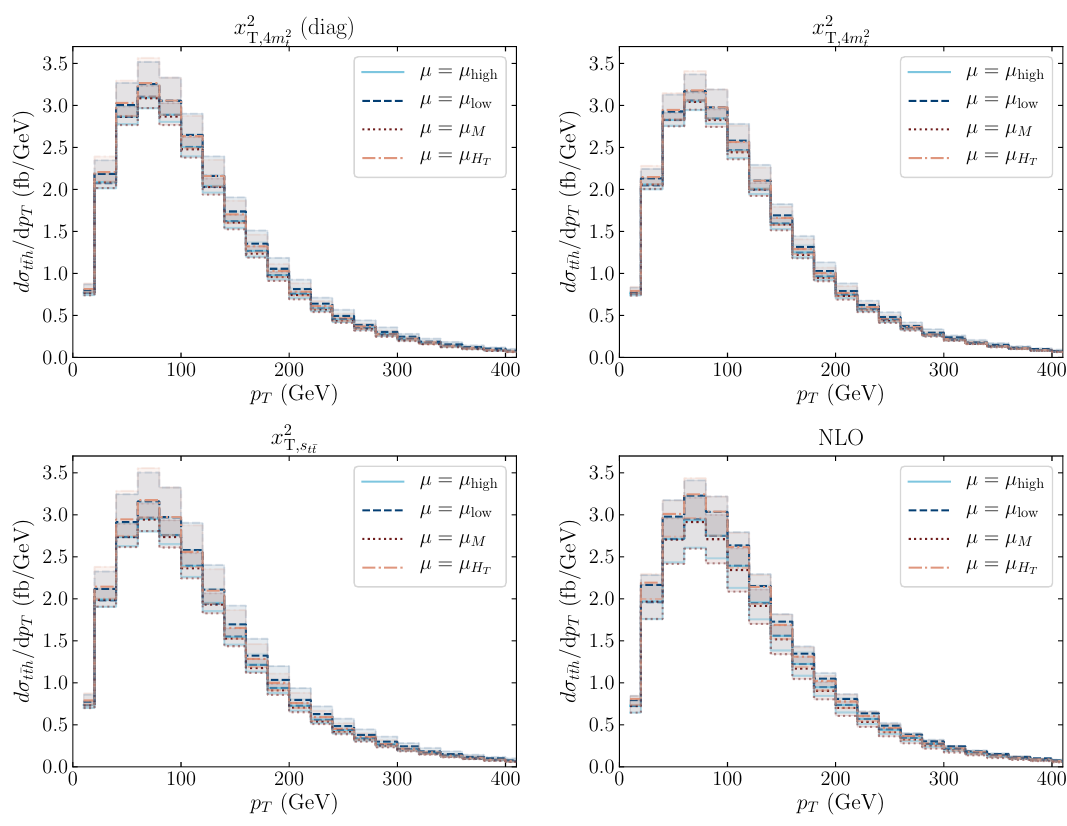
Figure 6 . Transverse-momentum distributions for the scale choices µ = µ high (light-blue solid), (orange dash-dotted). Shown µ = µ low (dark-blue dashed), µ = µ M (red dotted), and µ = µ H T are the matched resummed results using x 2 with/without approximating the soft-anomalous T, 4 m 2 t dimension matrix (upper left/right), x 2 (lower left) and the NLO result without resummation T,s t ¯ t (lower right). The colored bands indicate the scale uncertainty within each scale choice as obtained by varying µ between µ 2 and 2 µ , with µ the reference factorization/renormalization scale. ref / ref ref